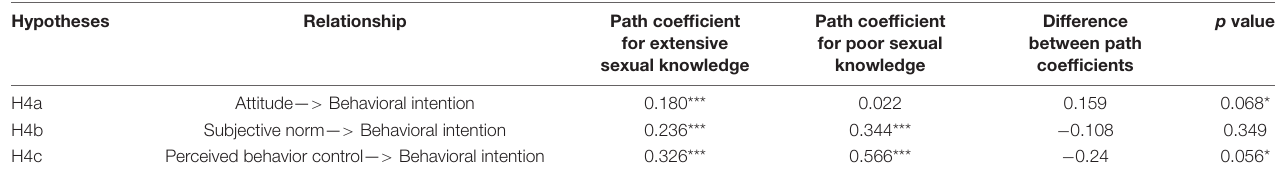
TABLE 4 | Multiple group analysis through partial least squares method (sexual